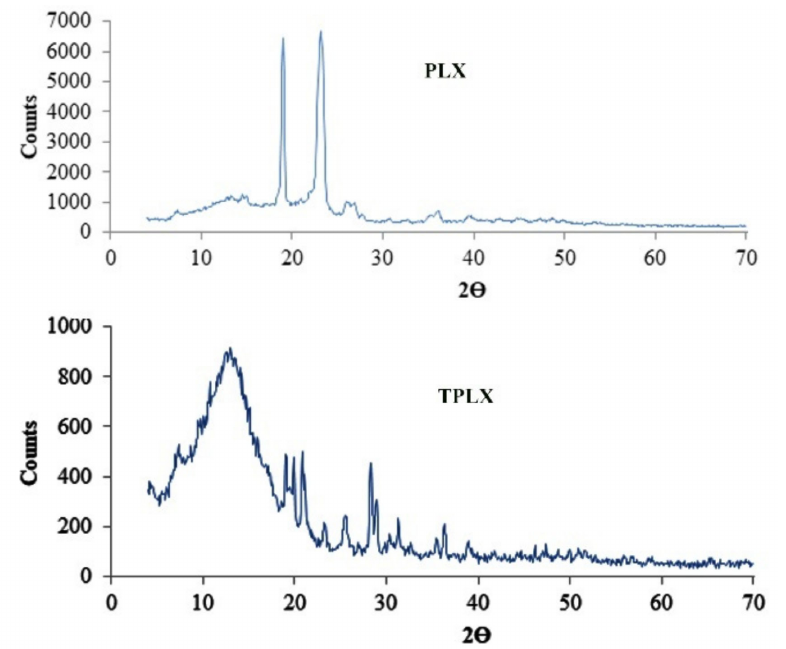
Figure 5. XRD diffractogram of PLX and TPLX exhibiting various peaks between 20 and 40. Sharp peaks present in the structure of PLX was found to be diminished in the graph of TPLX, indicating a noticeable change in its structure upon